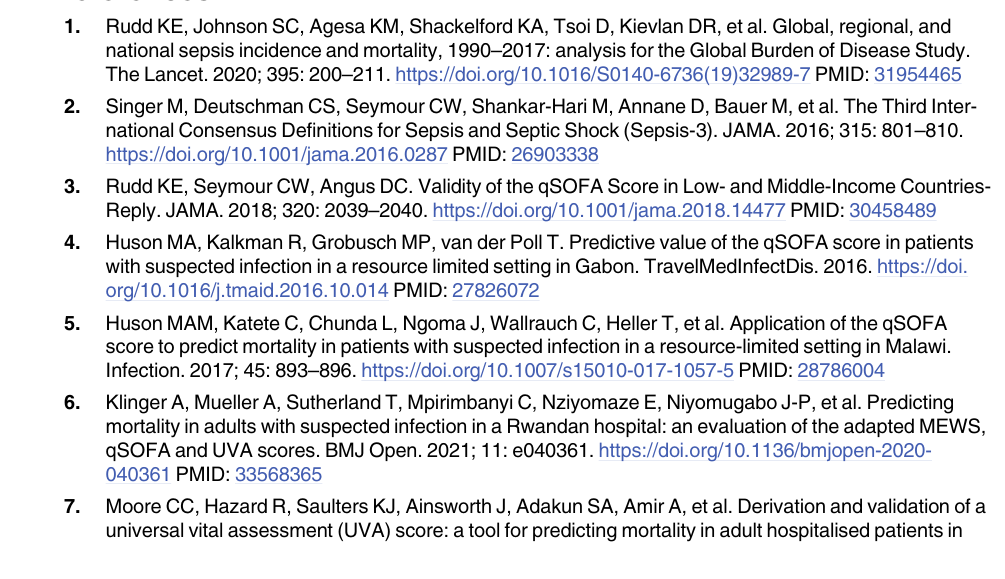
S1 Fig. Data collection tool used in the original study that generated data used in the exter- nal validation of the UVA score in Rwanda